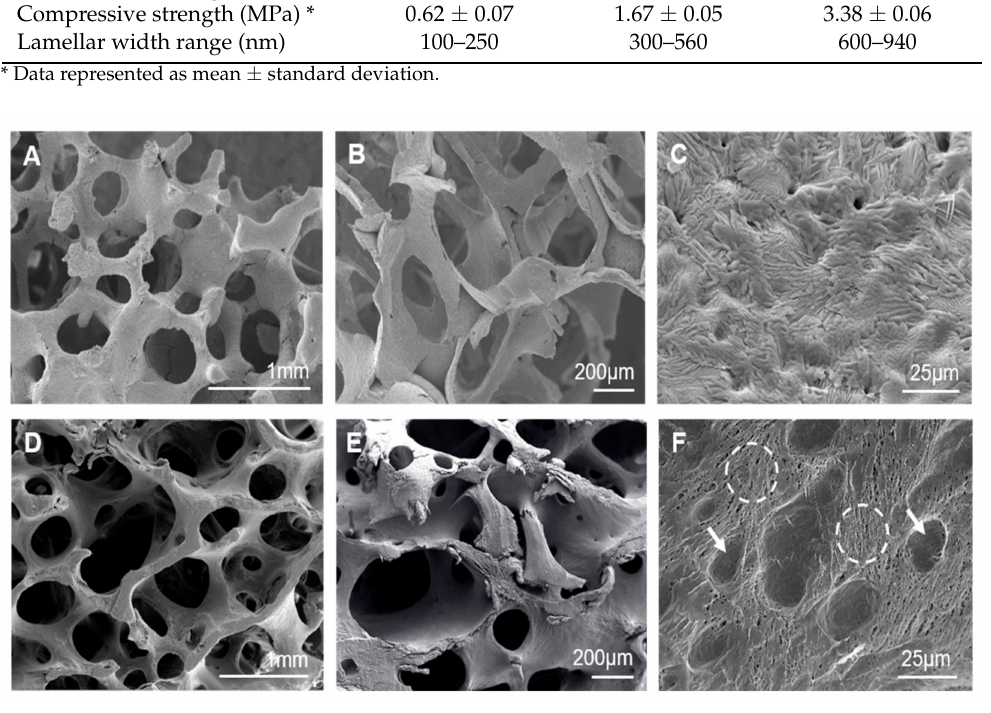
Figure 1. SEM micrographs at different magnifications showing the micro-/nano-structure of: ( A – C ) the eutectoid lamellar scaffold cooled at 50 ◦ C/h as being a representative sample of them all and ( D – F ) natural cancellous